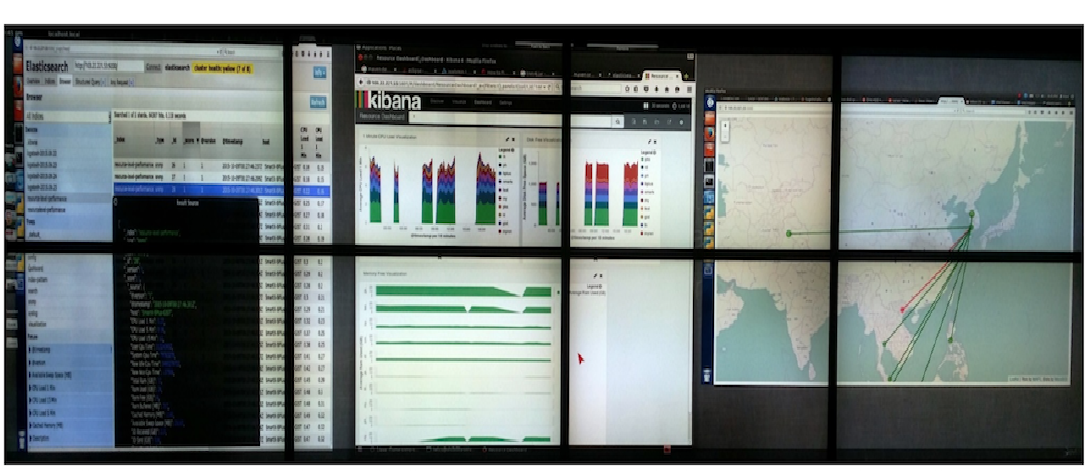
Figure 16. Multi-site playground resources visibility over network tiled